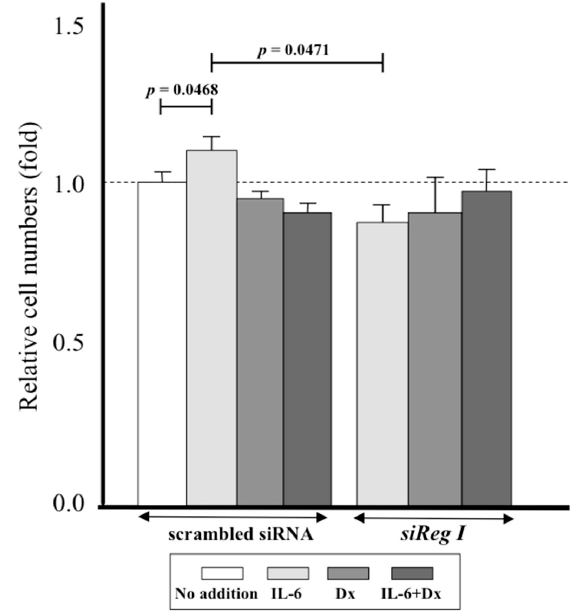
Figure 4. Effects of transfection with siRNA for Reg I on cell numbers of PMSCs. The WST-8 assay was performed using siRNA-transfected PMSCs (scrambled siRNA or siReg I ). These PMSCs were stimulated with IL-6, Dex, and IL-6+Dex or without stimulants (No addition), and the relative cell numbers were measured by cleavage of WST-8. The data are relative values compared with the absorbance of cells with “No addition” and indicated by mean ± SE ( n = 4).